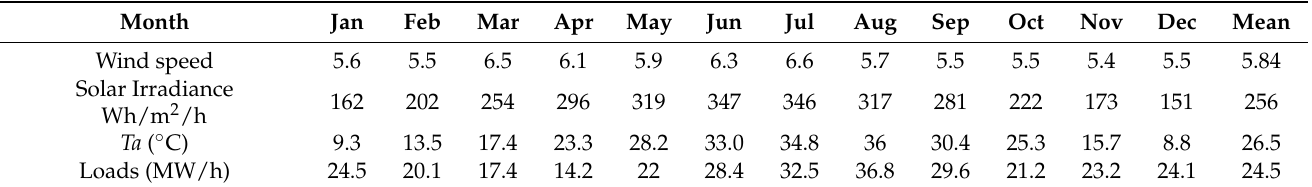
Table 1. Wind speed collected at 40 m above sea level, Solar irradiance on a horizontal surface, temperature, and loads for Dumah AlJandal site [1,67].